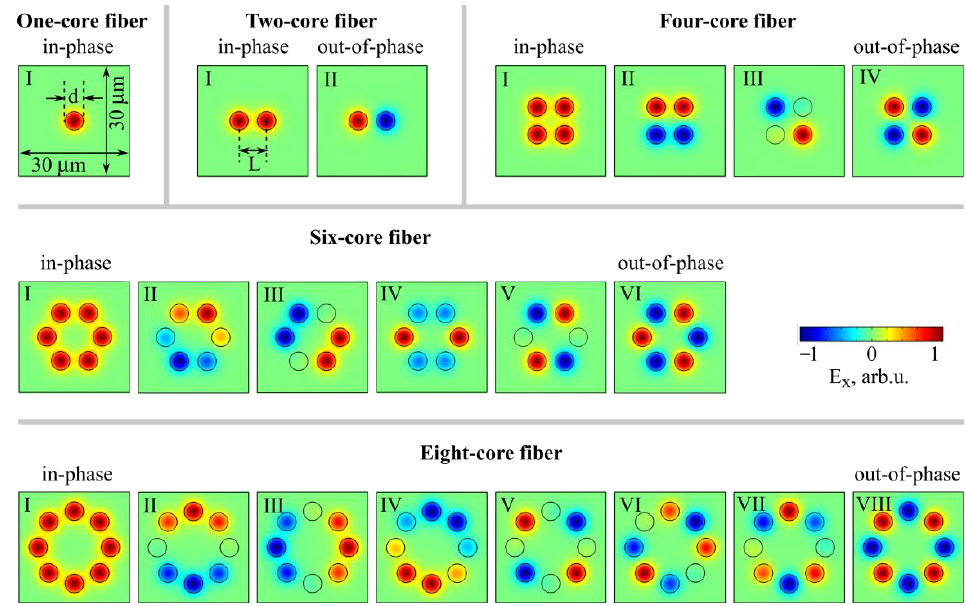
Figure 2. Examples of the fundamental mode field for a one-core fiber and fields of supermodes for two-core, four-core, six-core, and eight-core fibers. All calculations were made for TWL/TWL2 core/cladding glasses, d = 10 μm, L = 15 μm at a wavelength of 2 μm. The color bar shown near the six-core fiber is the same for all fibers.